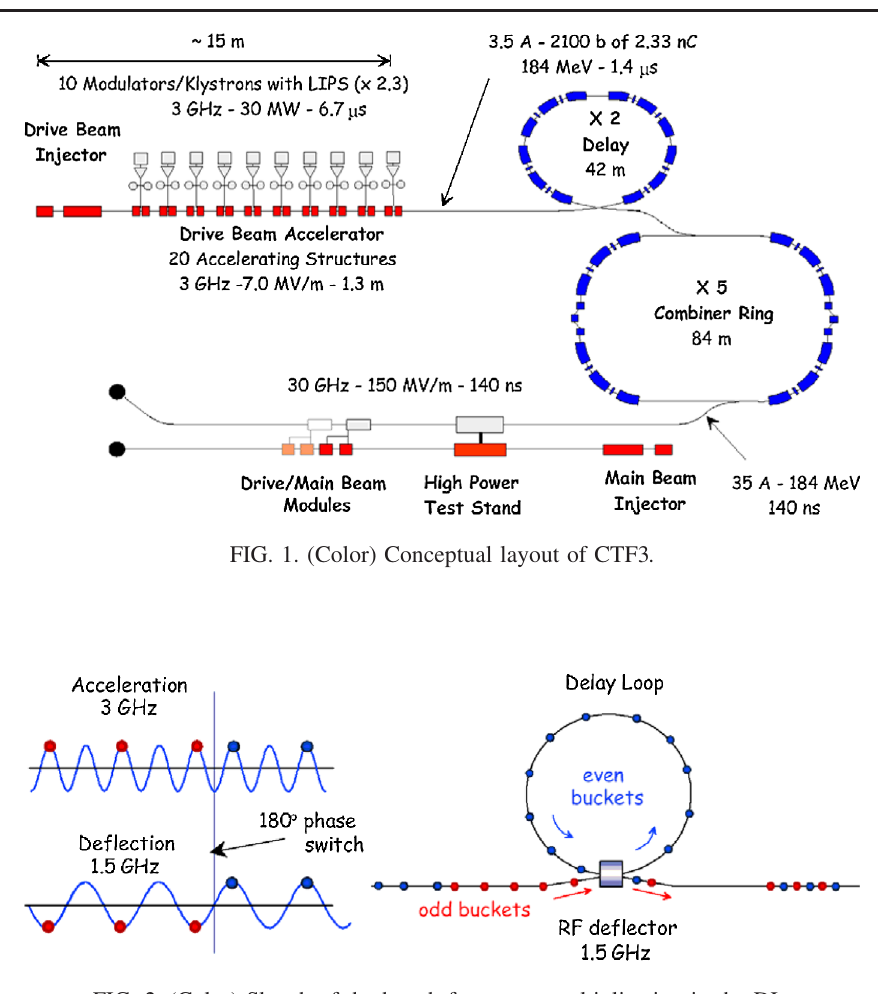
FIG. 2. (Color) Sketch of the bunch frequency multiplication in the